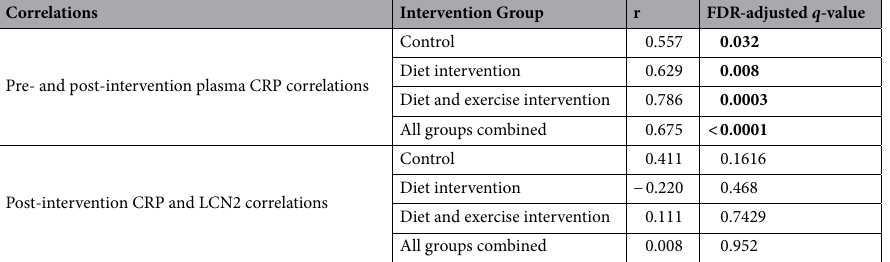
Table 10. Pearson’s correlations between measured plasma CRP (mg/l) concentrations pre- and post- interventions per group, as well as correlations with LCN2. Data are from two-tailed Pearson’s correlations, with q -values under 0.05 bolded. FDR, False Discovery Rate; LCN2, Lipocalin-2; CRP, C-reactive